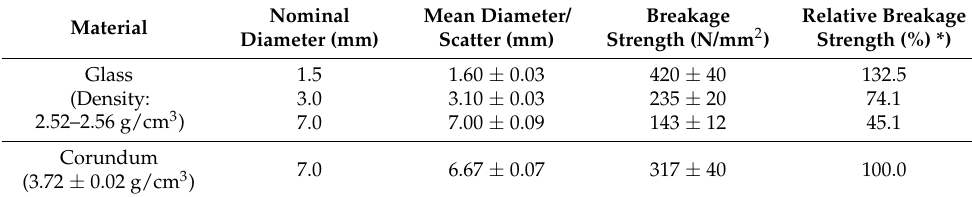
Table 1. Glass balls (G) and corundum balls (C), technical data.